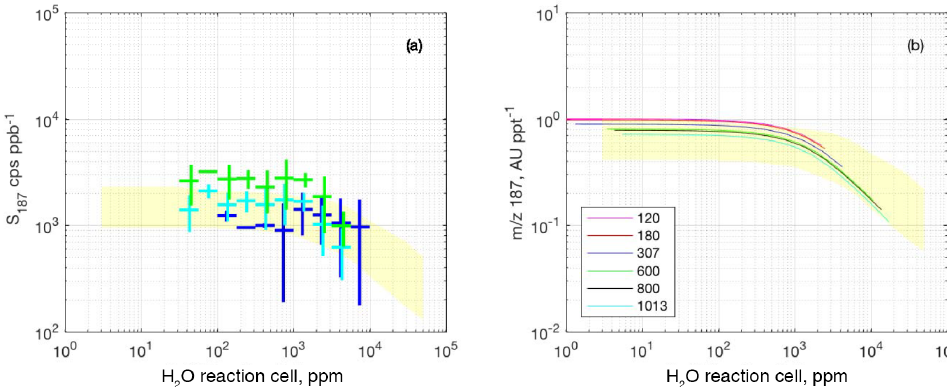
Figure 10. Same as Fig. 9 except for I − ( HAc ) . Field calibrations for HAc were not performed in DC3. (cid:0) (cid:1) ≈ (cid:0) (cid:1) E bond X − H 2 O 2 E bond X − CH 3 OOH < (cid:0) (cid:1) (cid:0) (cid:1) E bond X − HCl < E bond X − · HNO 3 . Last, ab